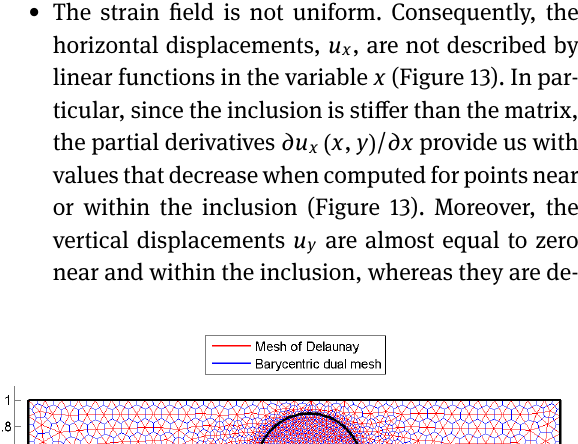
Figure 14: 3D plot of the vertical displacements u y .